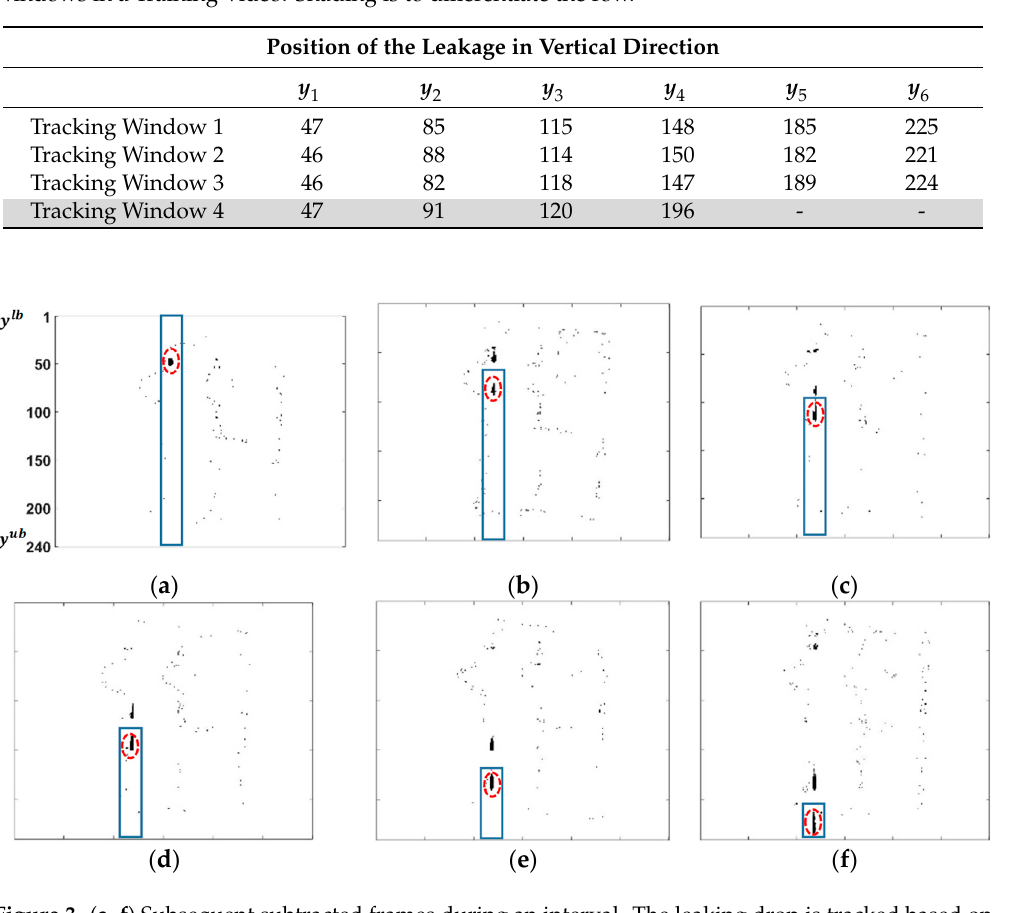
Table 2. An Example of Measurement Results of a Single Leaking Drop in Four Subsequent Tracking Windows in a Training Video. Shading is to di ff erentiate the row.